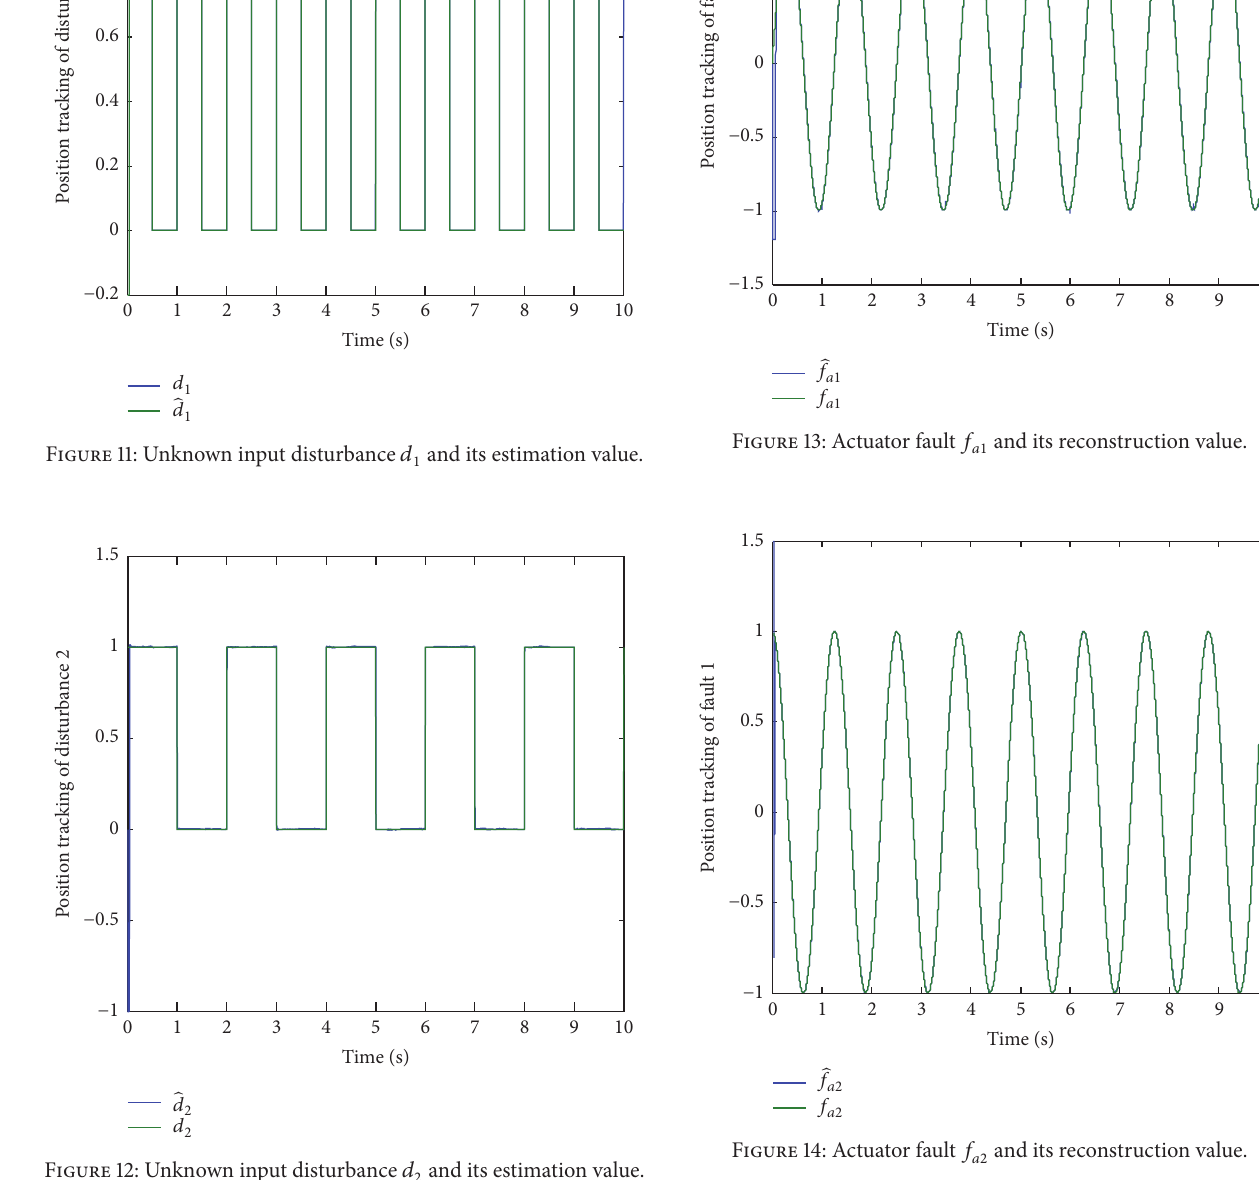
results indicate that the method can estimate the unknown disturbances and reconstruct the actuator faults accurately.